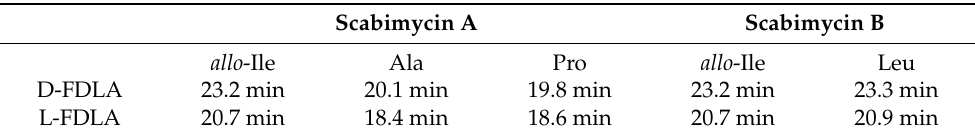
Table 1. Retention times of amino acids in scabimycins A and B after derivatization with D-FDLA and